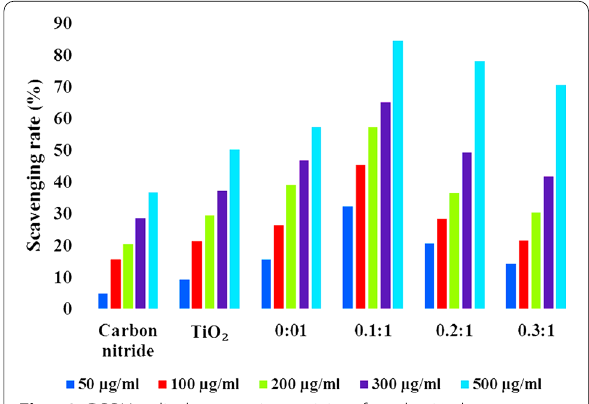
Fig. 10 DPPH radical scavenging activity of synthesized